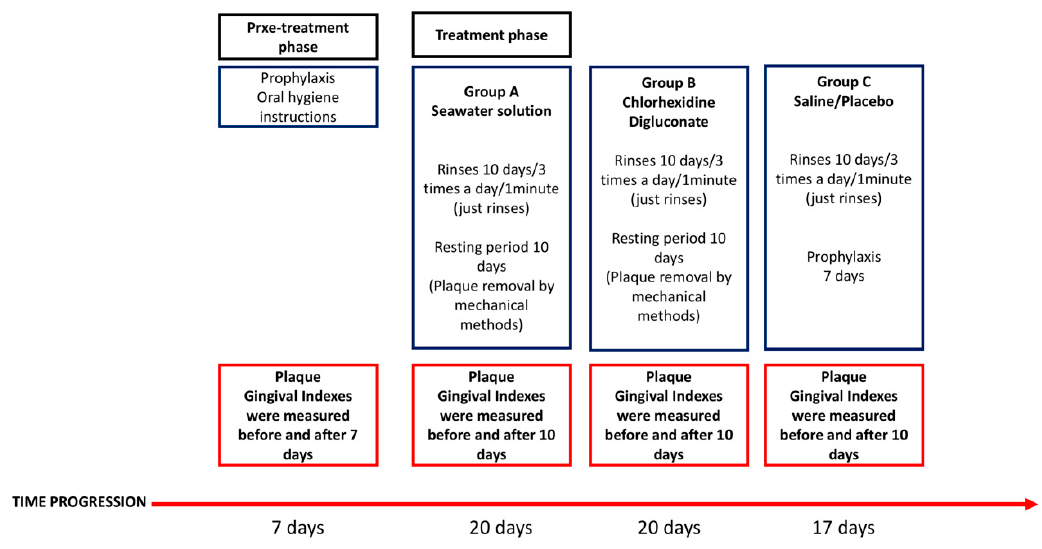
Figure 1. Material and methods following in this study.